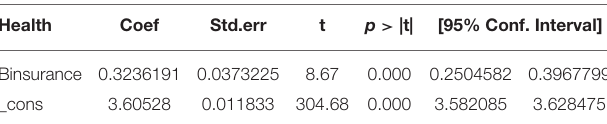
TABLE 7 | The direct effect.